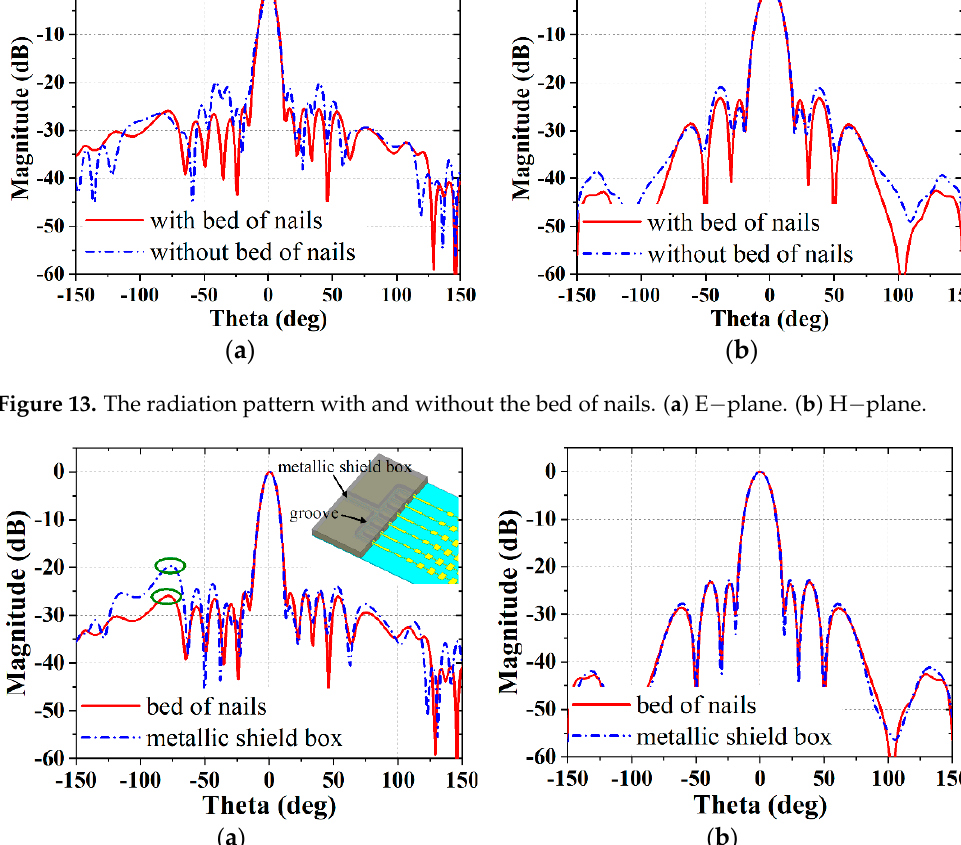
Figure 14. The radiation pattern of the proposed array and the radiation pattern of the planar array with the common package of a metal box. ( a ) E − plane. ( b ) H − plane.